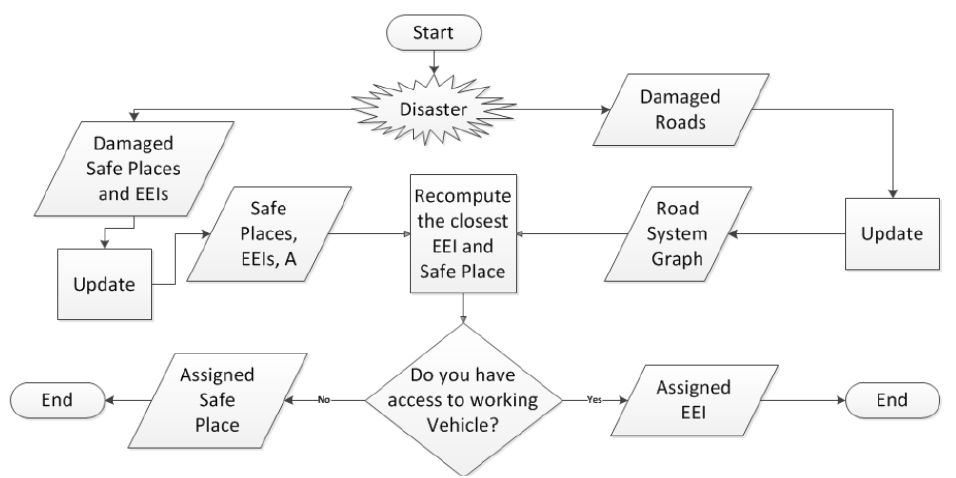
Figure 1. Flowchart of the proposed model for simulating evacuation.